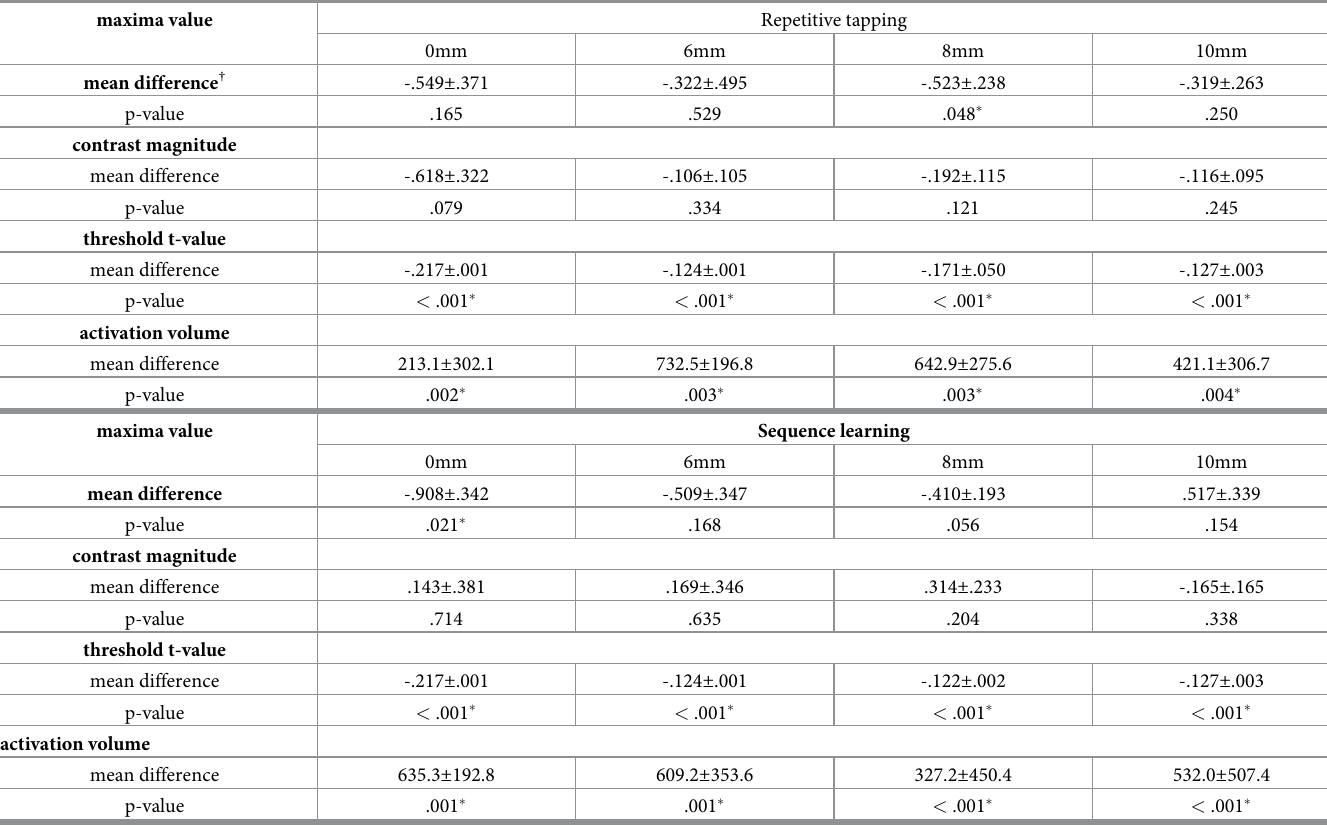
Table 2. Effects of voxel size on SMC